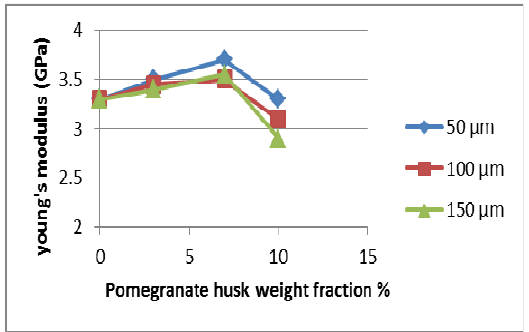
Fig. 10. Effect of pomegranate husk particles on young's